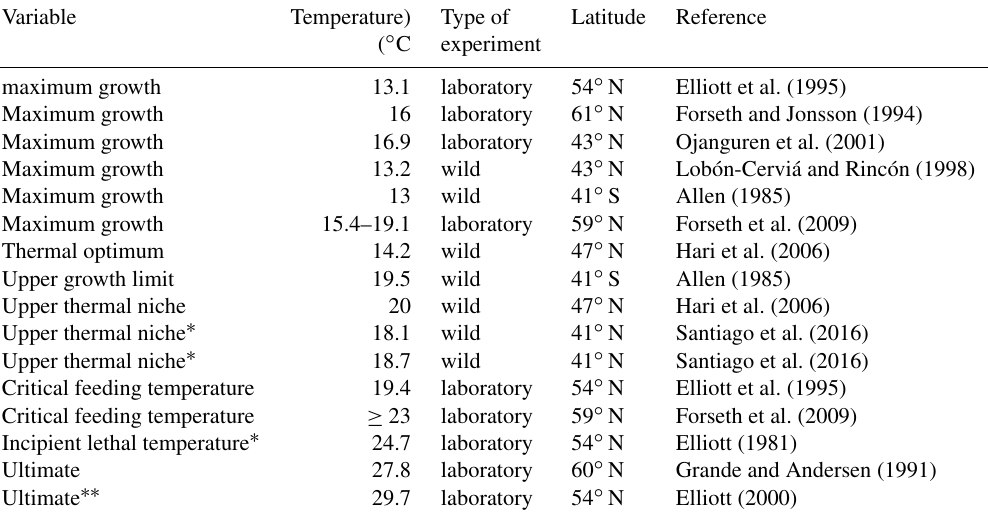
Table 3. Different classes of thermal thresholds for emerged trout classes found in the literature. The type of experiment differentiates the experiments with controlled (laboratory) and uncontrolled (wild) temperature. Latitude of the experiments’ location is